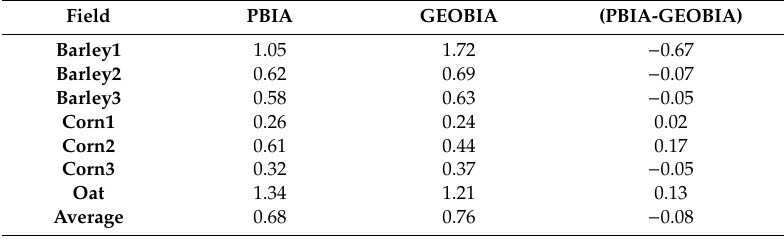
Table 13. Boundary mean positional error (in meters) computed by comparing the manually- and machine-delineated field boundaries for the pixel-based image analysis and geographic object-based image analysis